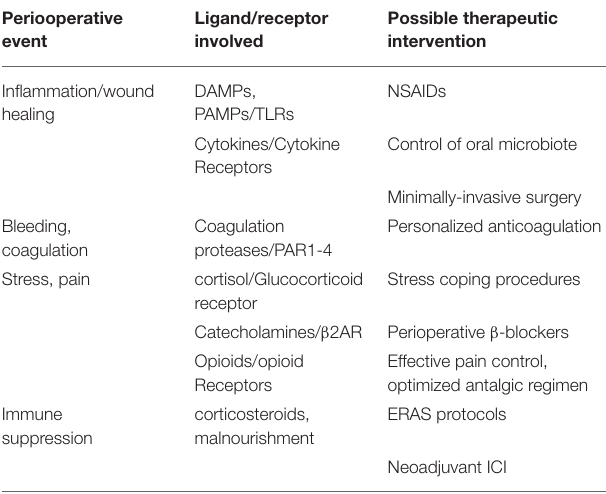
TABLE 1 | An overview of the main perioperative biological events, the ligands and receptors involved and the potential therapeutic interventions. Periooperative